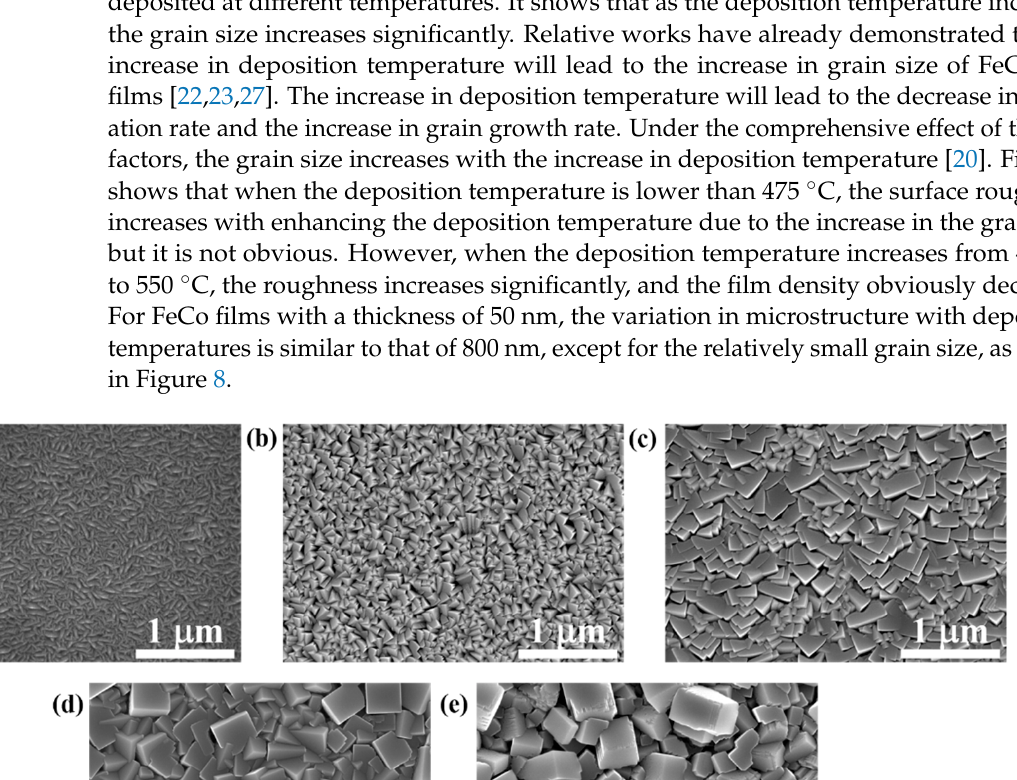
Figure 5. GI-XRD patterns for FeCo thin films with thickness of 50 nm deposited at different tem- peratures.